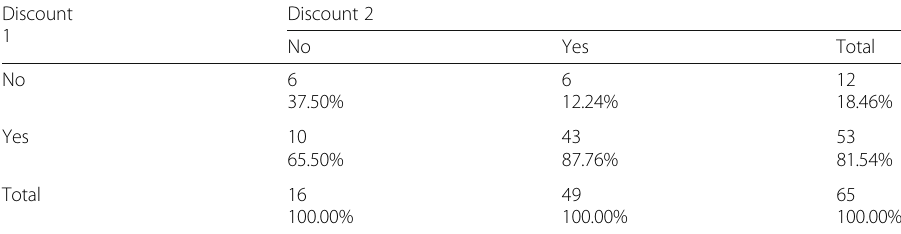
Table 8 Count and frequency of discount